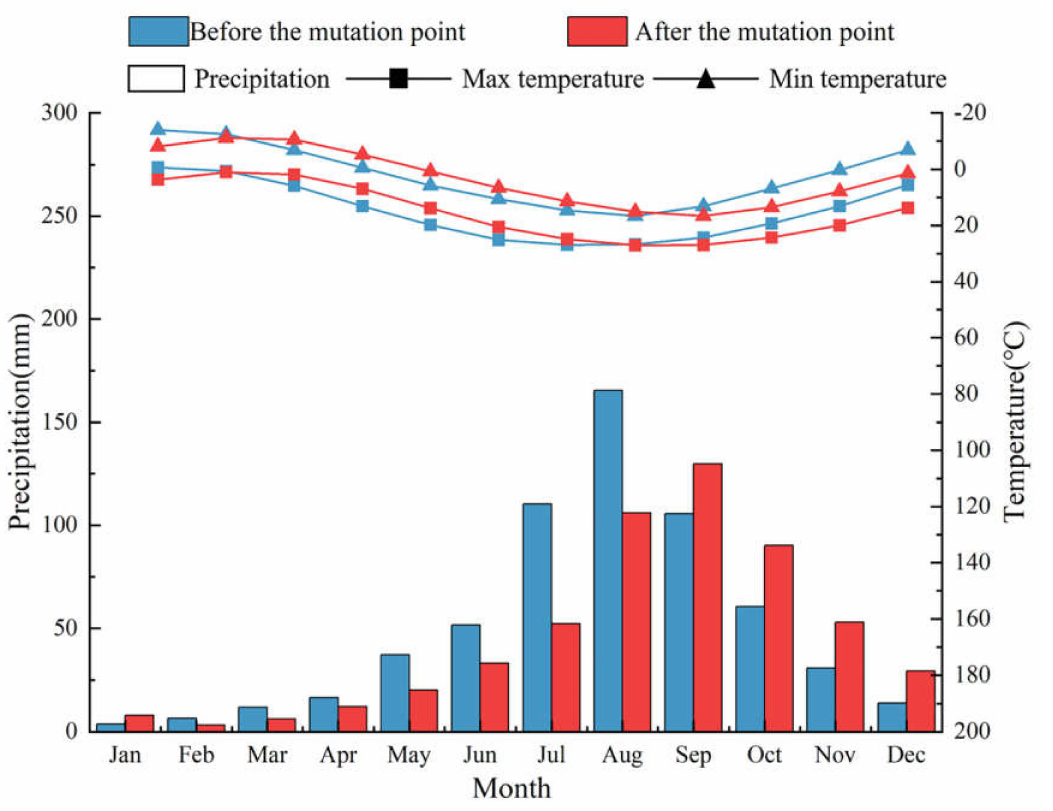
Figure 6. Change in precipitation and temperature before and after the mutation